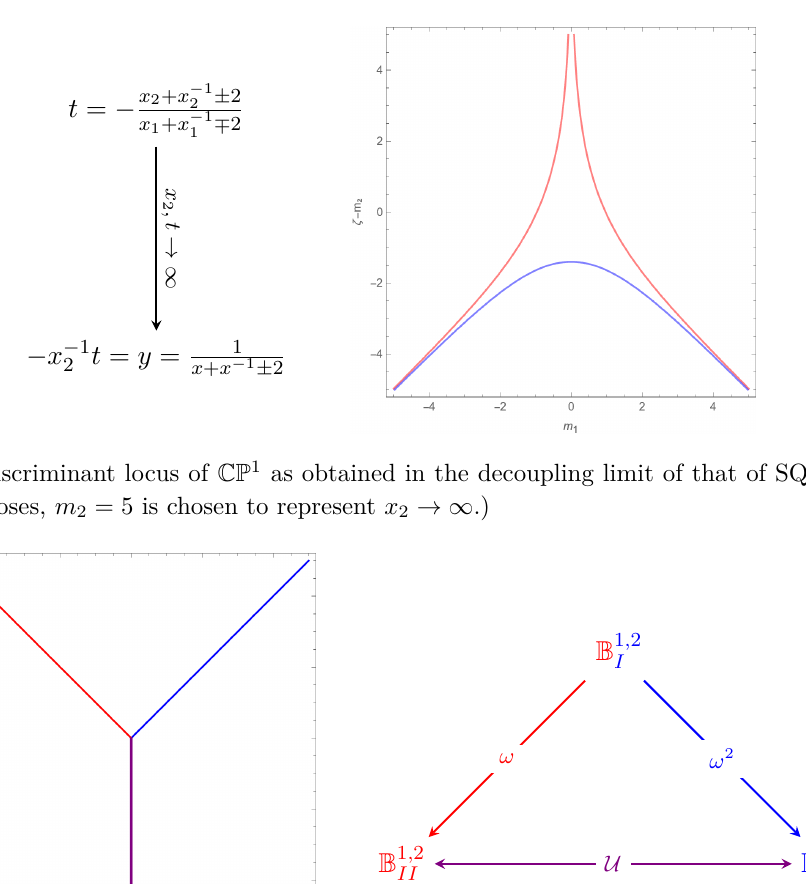
Figure 6 . Left: the three Stokes regions of the CP 1 model as obtained in the decoupling limit of SQED model (again, m = 5 represents x as in figure 5). Right: the associated holomorphic 2 2 2 → ∞ blocks and the relevant transformations, which act only on the J -functions appearing inside B ’s. (The complete blocks are then obtained by multiplying J ’s with appropriate prefactors, as in the case of SQED 2